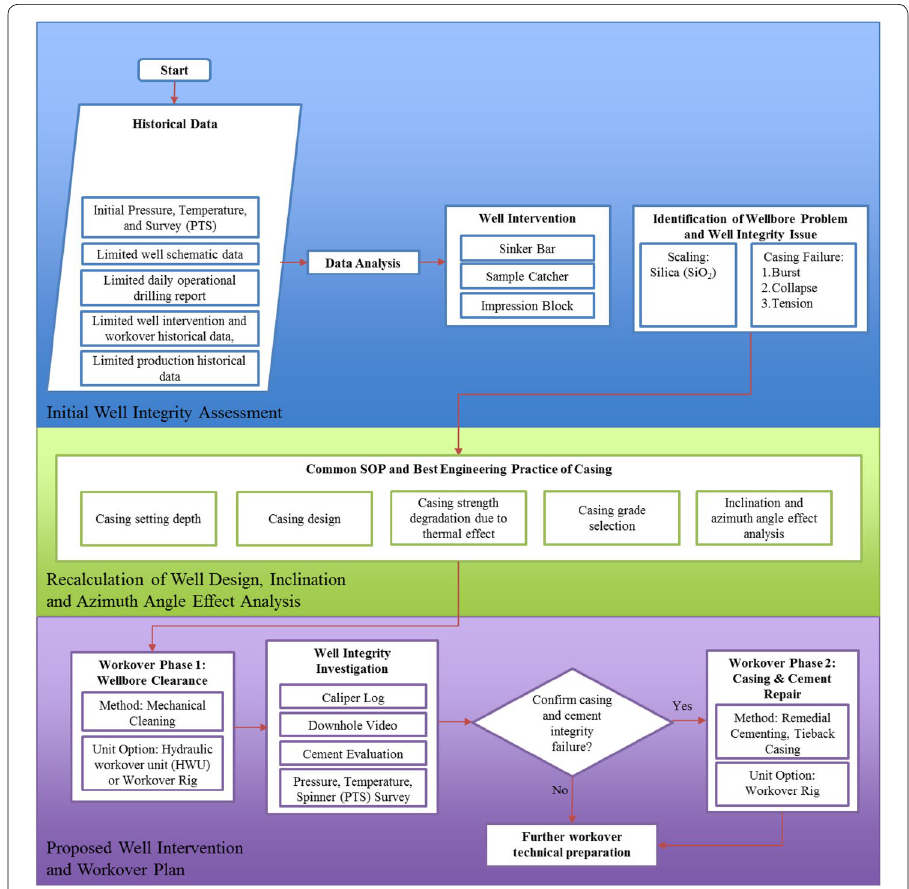
Fig. 1 The methodology of casing failure analysis for long-abandoned geothermal wells HCE9B and